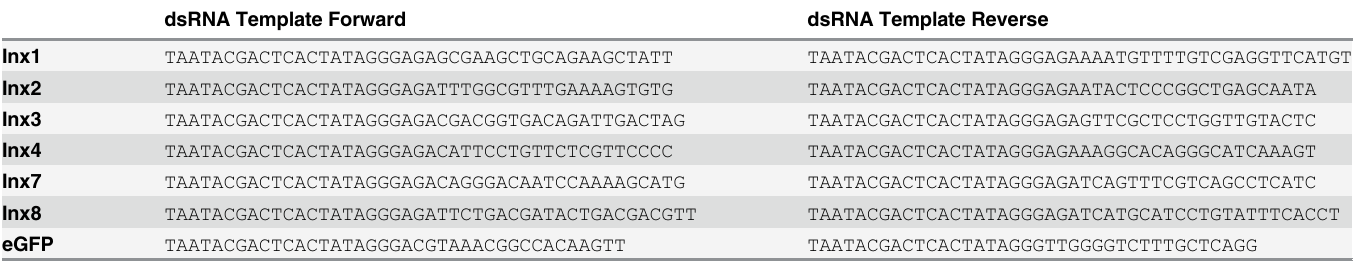
Table 1. dsRNA template synthesis primers. Each primer set consists of an innexin specific region for amplification of the target gene from plasmid, and the T7 promoter sequence ( TAATACGACTCACTATAGGGAGA ). dsRNA Template